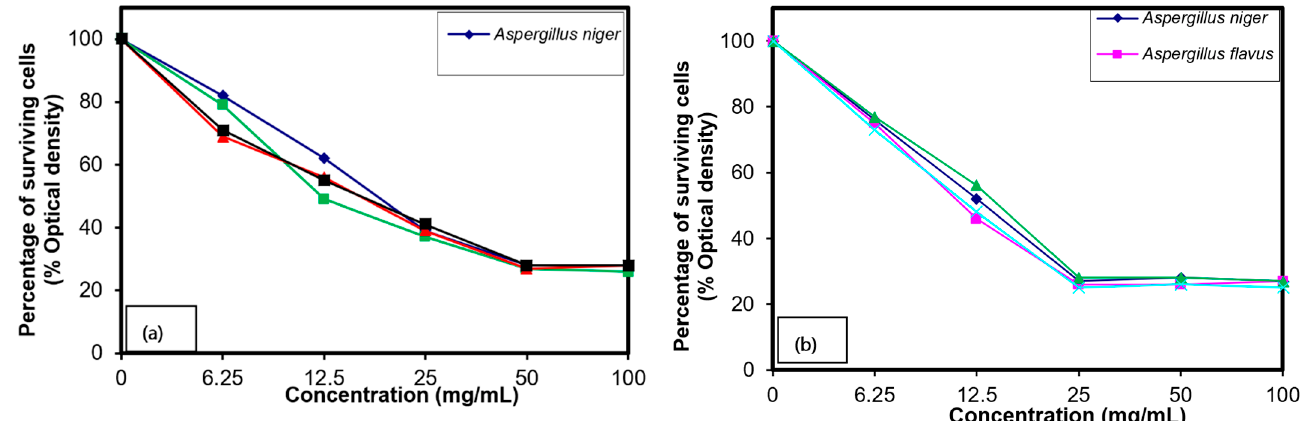
Figure 4. Growth inhibition against the various microorganisms examined of different polymer concentrations ( a ) VI and ( b ) VII.